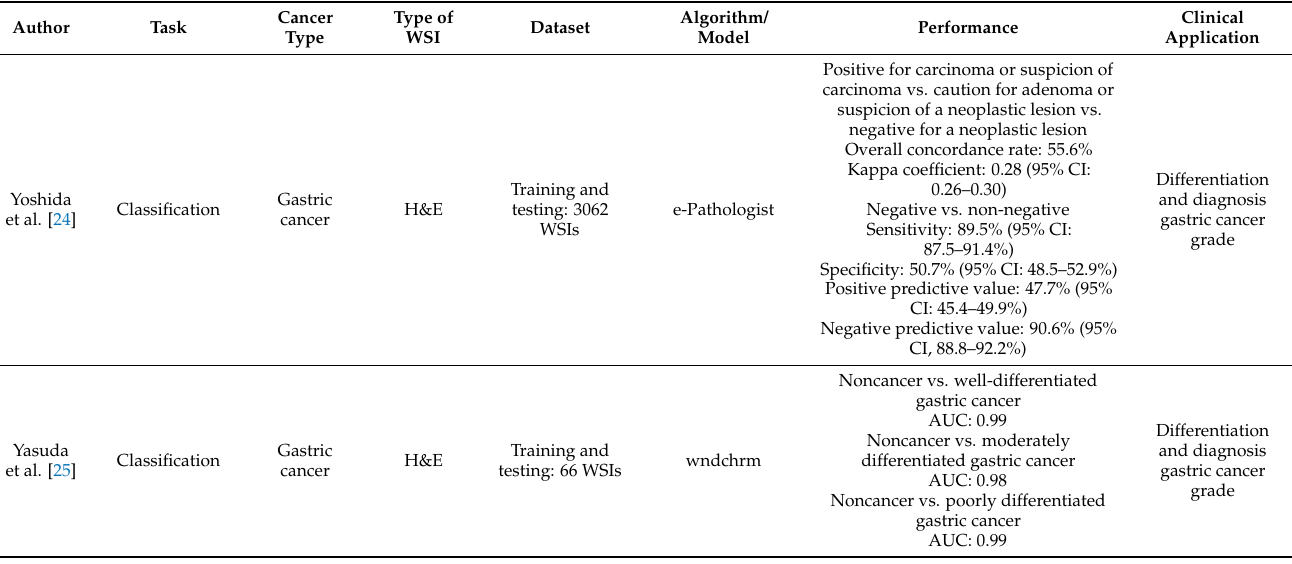
Table 1. Histopathologically related machine learning models used for clinical applications in GI can- cers. Machine learning algorithms and models are grouped according to their specific computational task and GI cancer type to compare their performance and clinical application. The sources of the datasets and sample sizes are also